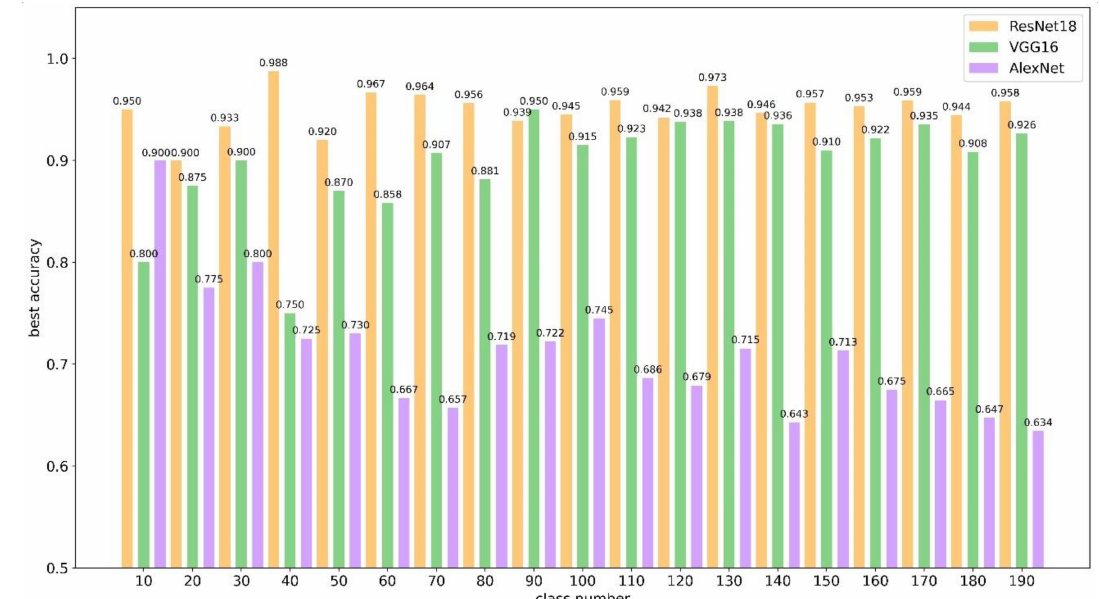
Figure 7. Accuracy of three different face classifiers with transfer